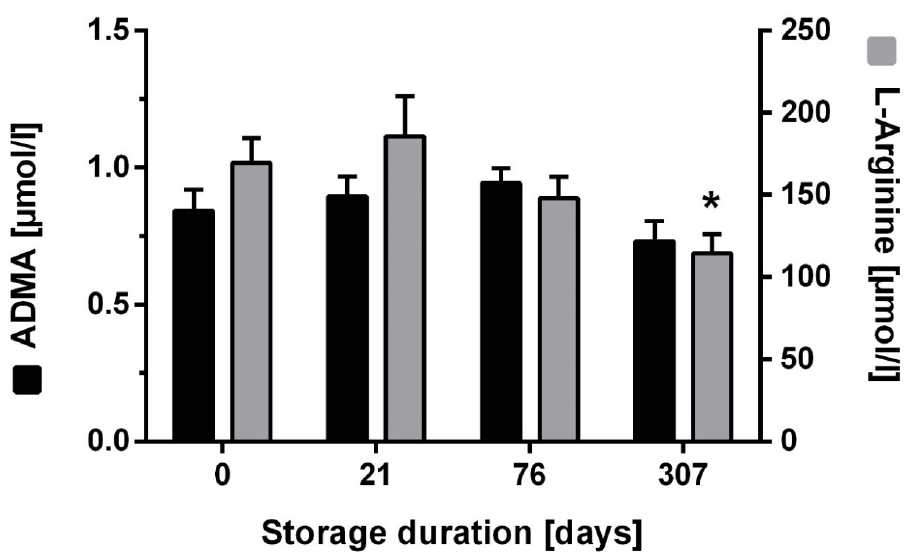
Figure 3. Effect of long-term storage at room temperature on dried blood spot assay results. ADMA and L-arginine were measured from dried blood spots on filter cards that had been pretreated with nor-NOHA and stored for up to 307 days at room temperature. Data are presented as mean ± SD; * p < 0.05 vs. day 0.